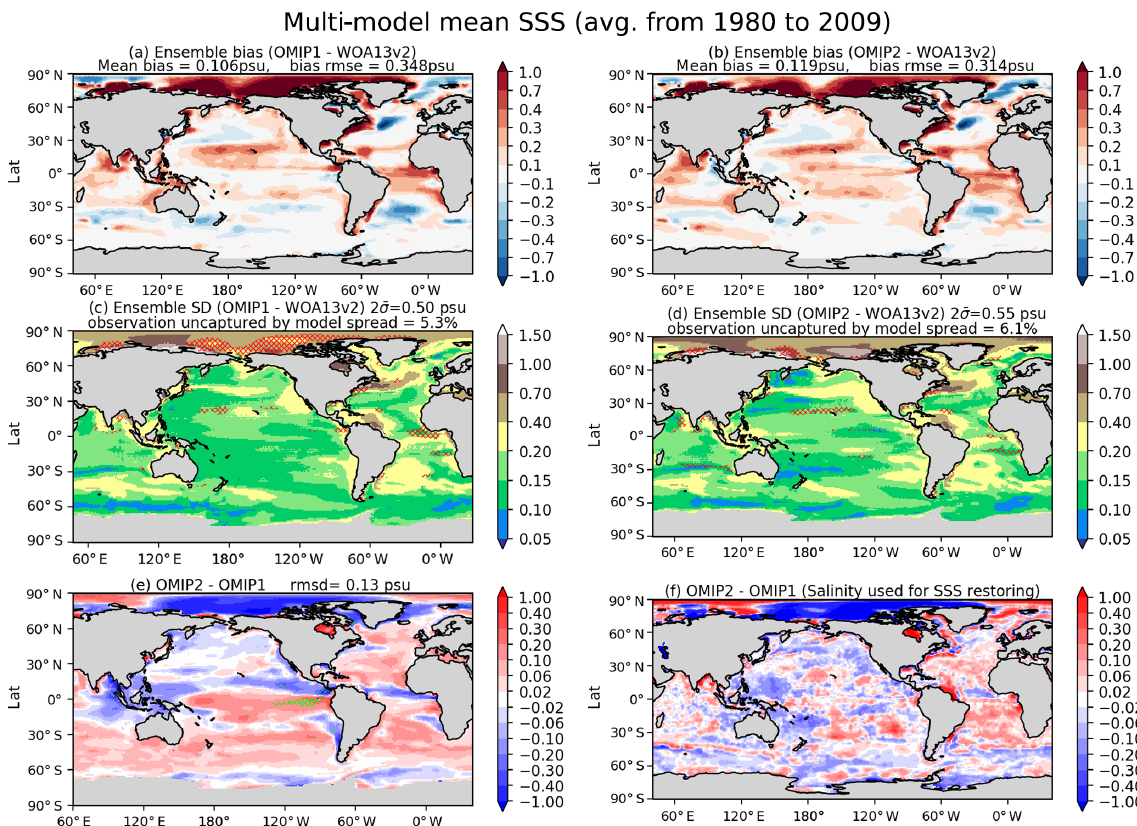
Figure 7. Evaluation of simulated sea surface salinity (SSS; units in psu). Panels (a) and (b) show the bias of the multi-model mean 30-year (1980–2009) mean SSS relative to WOA13v2 (Zweng et al., 2013). (a) OMIP-1 and (b) OMIP-2. The middle two panels show the standard deviation of the ensemble, with the regions where the observation is outside the 95% confidence range of the model spread ( ± 2 σ ) hatched with red. (c) OMIP-1 and (d) OMIP-2. (e) Difference between OMIP-1 and OMIP-2 (OMIP-2 minus OMIP-1), with the regions where the difference is significant at 95% confidence level hatched with green as in Fig. 6. (f) Difference of salinity to which sea surface salinity is restored in OMIP-1 and OMIP-2 (OMIP-2 minus OMIP-1). At the top of each panel, global mean values are depicted as in Fig. 6. See Figs. S13–S15 for results of individual